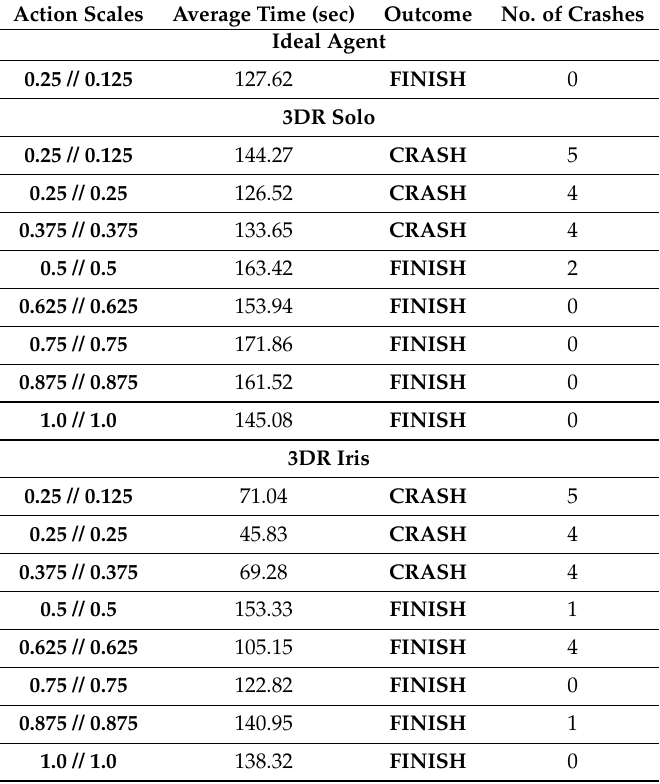
Table 5. Local Controller Test